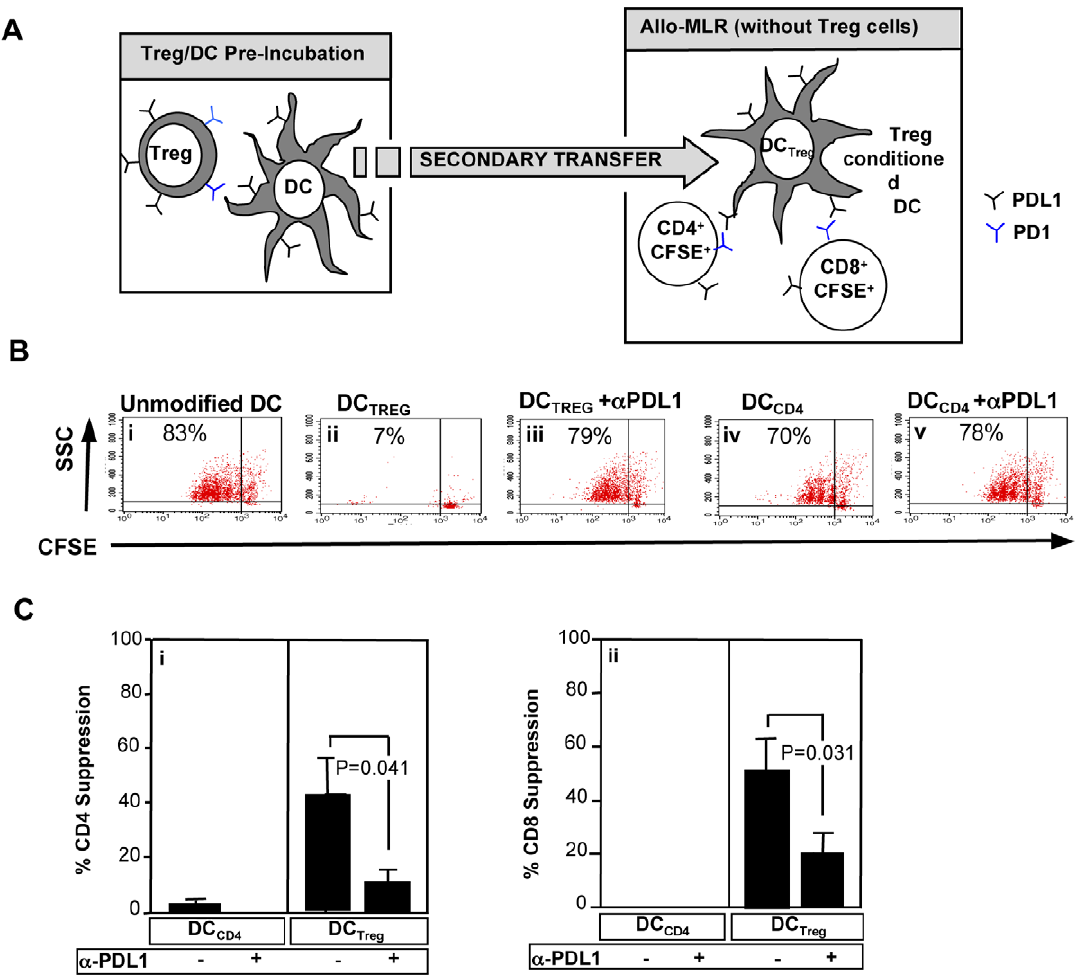
Figure 2. Treg-conditioned DC have reduced allostimulatory function in part through PD-L1. (A) Experimental schema for the allo-MLR using Treg-conditioned DC. Control CD4 cells or Tregs were generated ex vivo and then utilized to condition allogeneic DC (24-h incubation; 1:1 cell ratio). Conditioned DC were then purified by negative selection using anti-CD3 microbeads and utilized as the stimulator population (DC to responder T cell ratio, 1:20). The allo-MLR was performed in the presence of anti-PD-L1 or isotype control antibody. (B) Representative CFSE dye dilution proliferation assay results, including responder CD4 alloreactivity in response to: unmodified DC (i); DC conditioned with Tregs either without (ii) or with (iii) addition of anti–PD-L1; and DC conditioned with control CD4 cells either without (iv) or with (v) anti–PD-L1. (C) Percent inhibition of responder CD4 cell proliferation (i) and responder CD8 cell proliferation (ii) were calculated relative to proliferation measured using sham-treated DC. Results are mean 6 SEM of n =8 normal donors